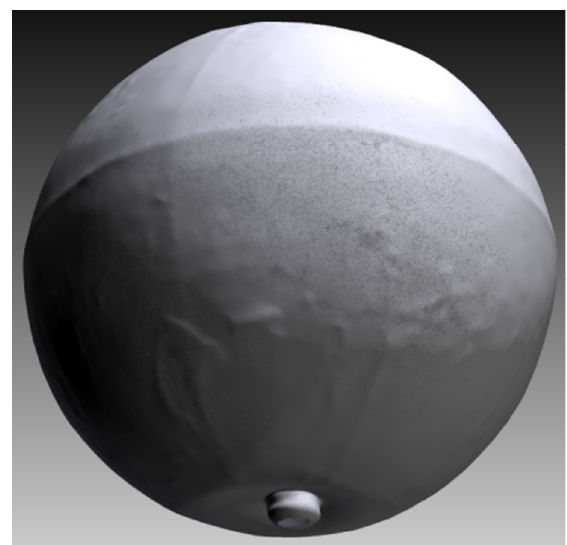
Fig. 7: A 1 million polygons decimated mesh of the globe. Small geometric imperfections (“bubbles”) are still visible despite the low- resolution geometric